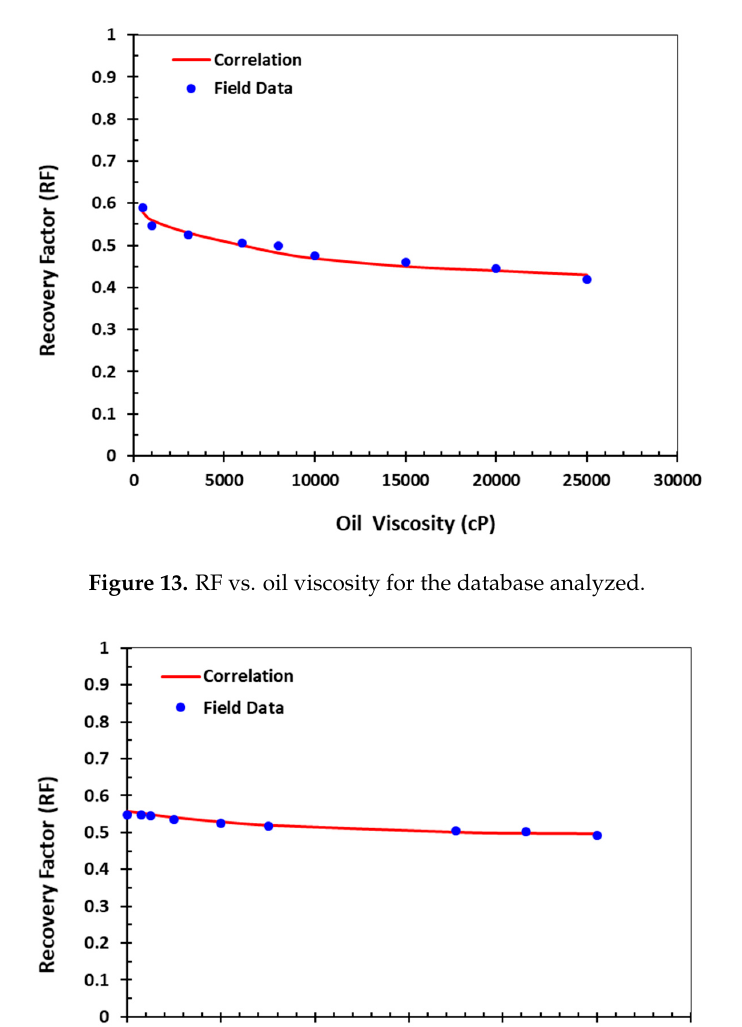
Figure 11. RF vs. steam flow rate for the database analyzed. Figure 12. RF vs. steam flow rate for the database analyzed. Energies 2018 , 11 , x FOR PEER REVIEW